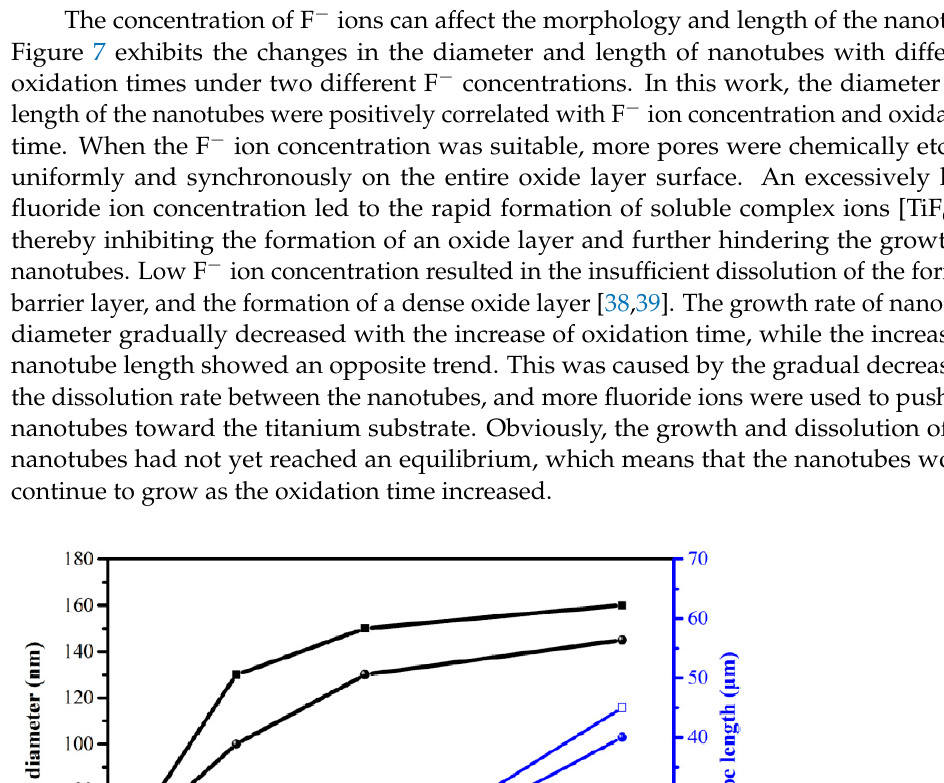
Figure 6. SEM images of top view of TiO 2 nanotube arrays before ( a – d ) and after ( e – h ) annealing with different oxidation times in electrolyte with 0.5 wt% NH 4 F: ( a , e ) 2 h; ( b , f ) 5 h; ( c , g ) 10 h; ( d , h ) 20 h. Inserts show side view of TiO 2 nanotube arrays.